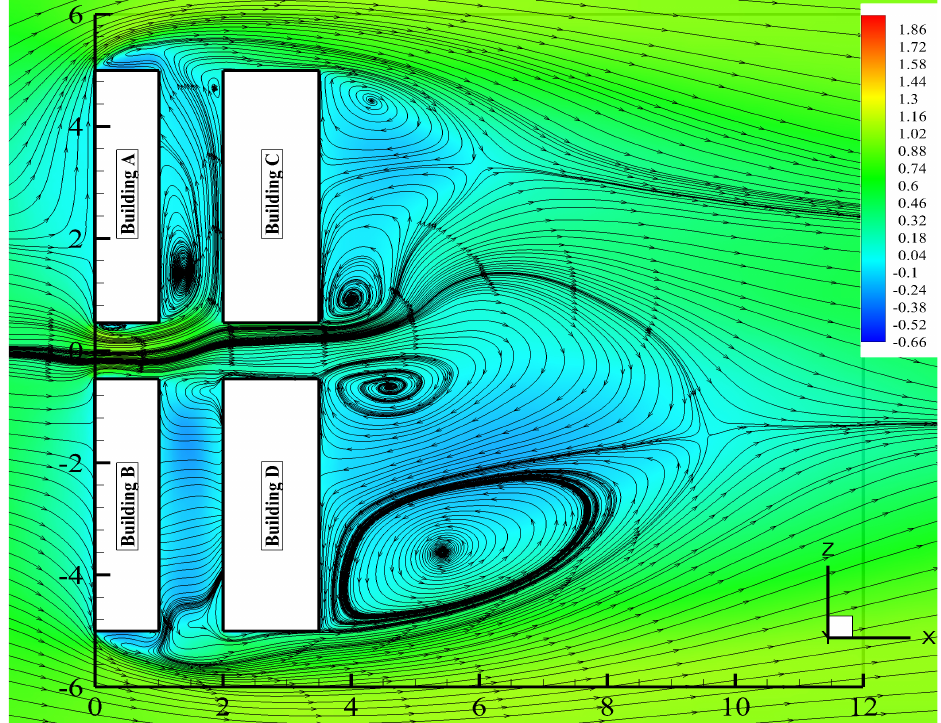
Figure 15. Contour and streamlines of time-averaged normalized velocity magnitude (cid:104) U (cid:105) / u H on x − z plane at y / H =